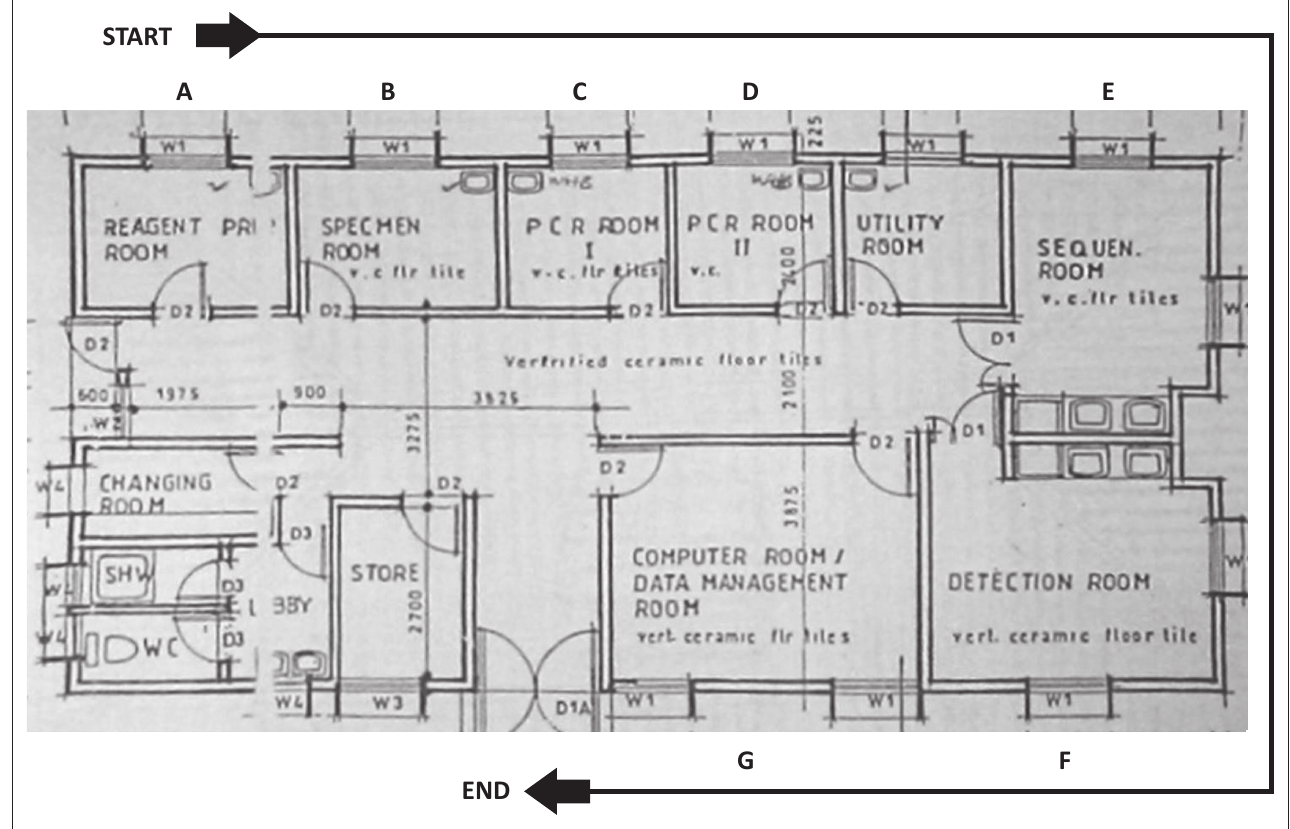
FIGURE 2: Infrastructure updates made to Jos University Teaching Hospital in Jos, Plateau